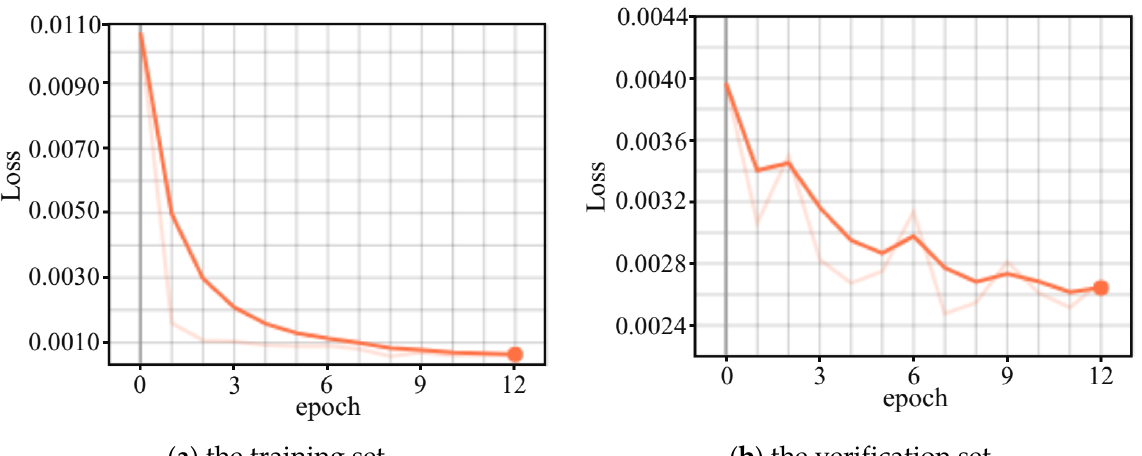
Figure 6. The result of loss for determining epoch.